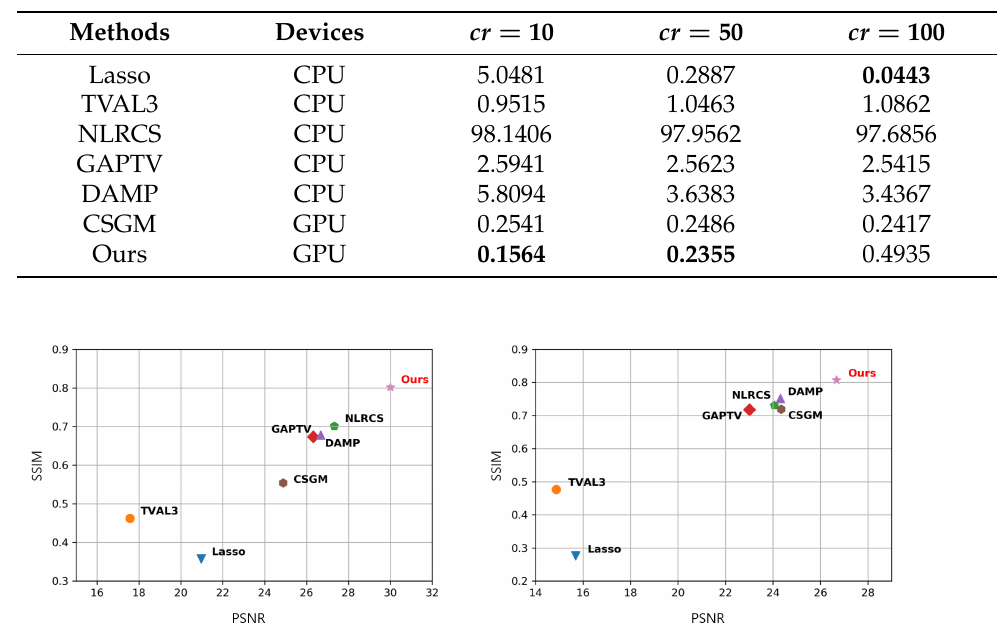
Figure 5. Comparison of PSNR and SSIM at the compression rate of 20. The results of various methods on plant seedling images ( left ) and the CalebA dataset ( right ) are shown.